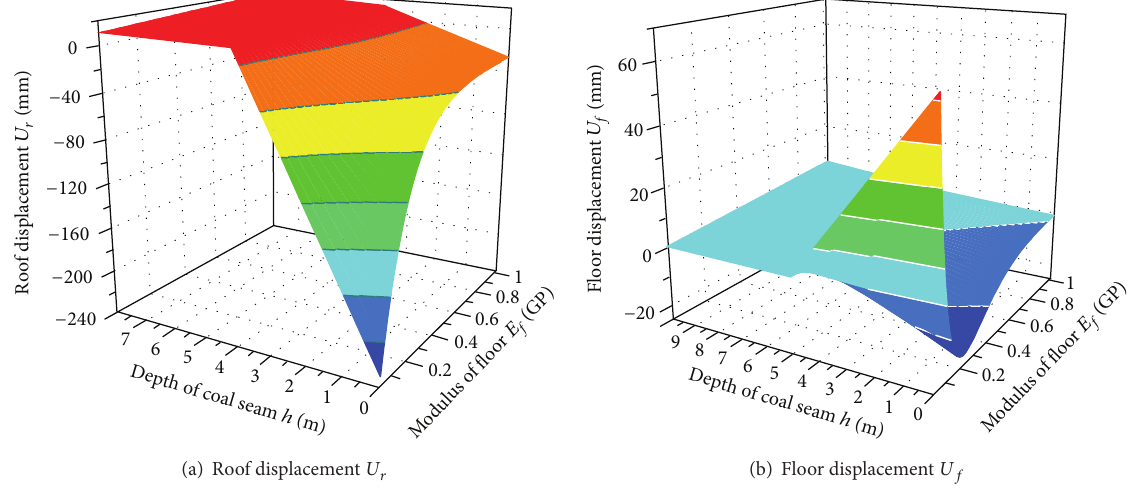
Figure 11: System responses with changes of